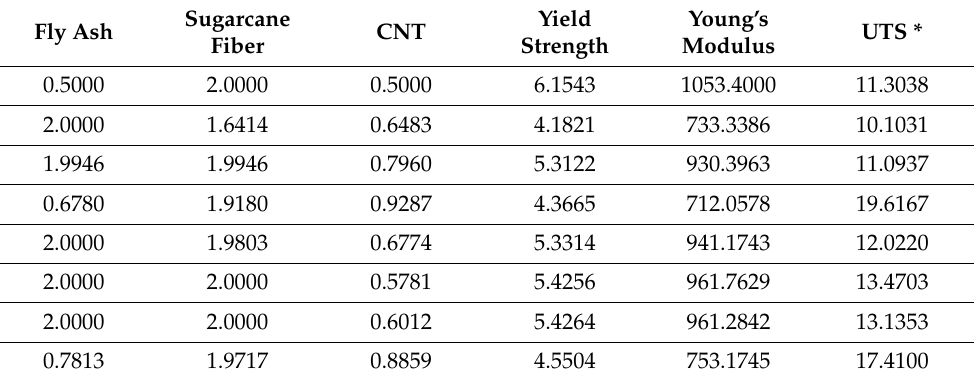
Table 7. Optimizing the objectives {YS, YM} with constraints imposed on input parameters {fly ash, SCF, CNT} ≥ 0.5.